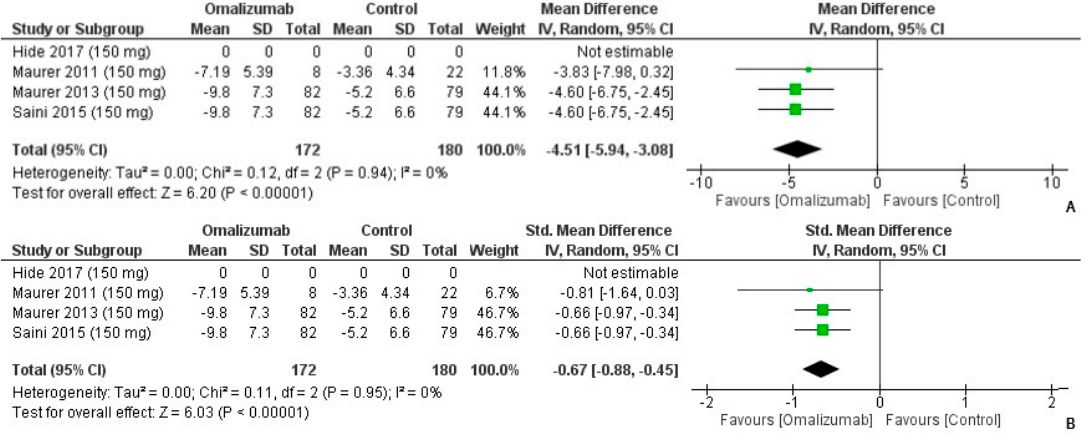
Figure 6. Weekly Wheal Score Outcomes with 150 mg dosage of omalizumab [17 − 19,26]. ( A ): Mean difference: − 4.51 [95% CI: − 5.94, − 3.08]; Heterogeneity: Tau² = 0.00; Chi² = 0.12, df = 2 ( p = 0.94); I² = 0%; Test for overall effect: Z = 6.20 ( p < 0.00001). ( B ): Standardized mean difference: − 0.67 [95% CI: − 0.88, − 0.45]; Heterogeneity: Tau² = 0.00; Chi² = 0.11, df = 2 ( p = 0.95); I² = 0%; Test for overall effect: Z = 6.03 ( p < 0.00001).